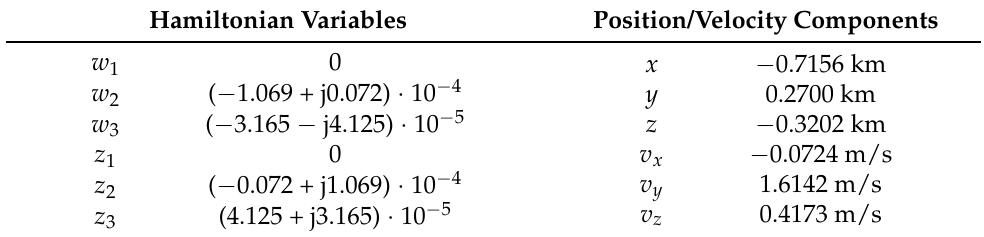
Table 9. Mid-inclination eccentric LEO formation: J n -invariant initial state of deputy satellite.